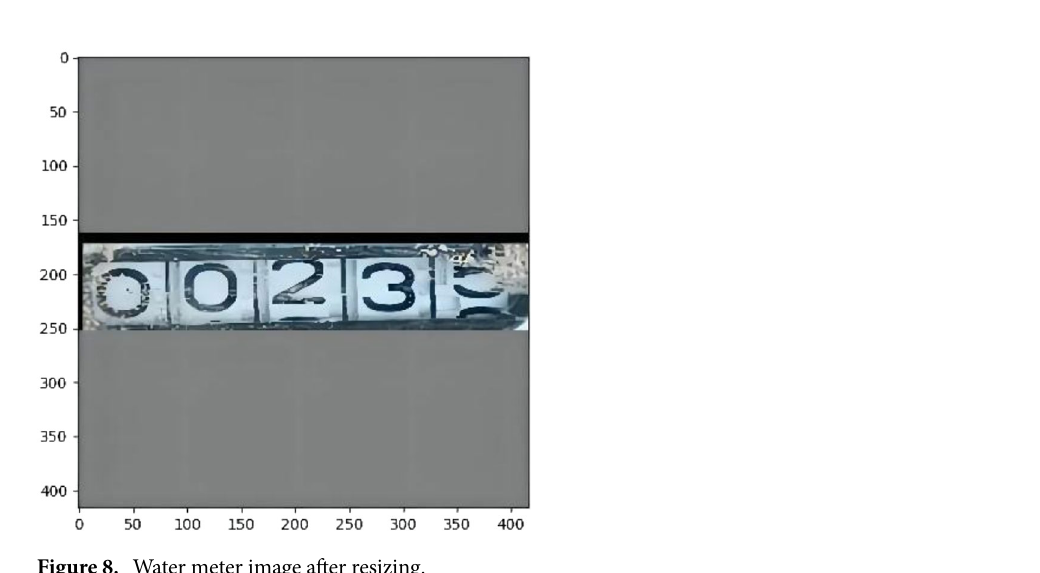
Figure 8. Water meter image after